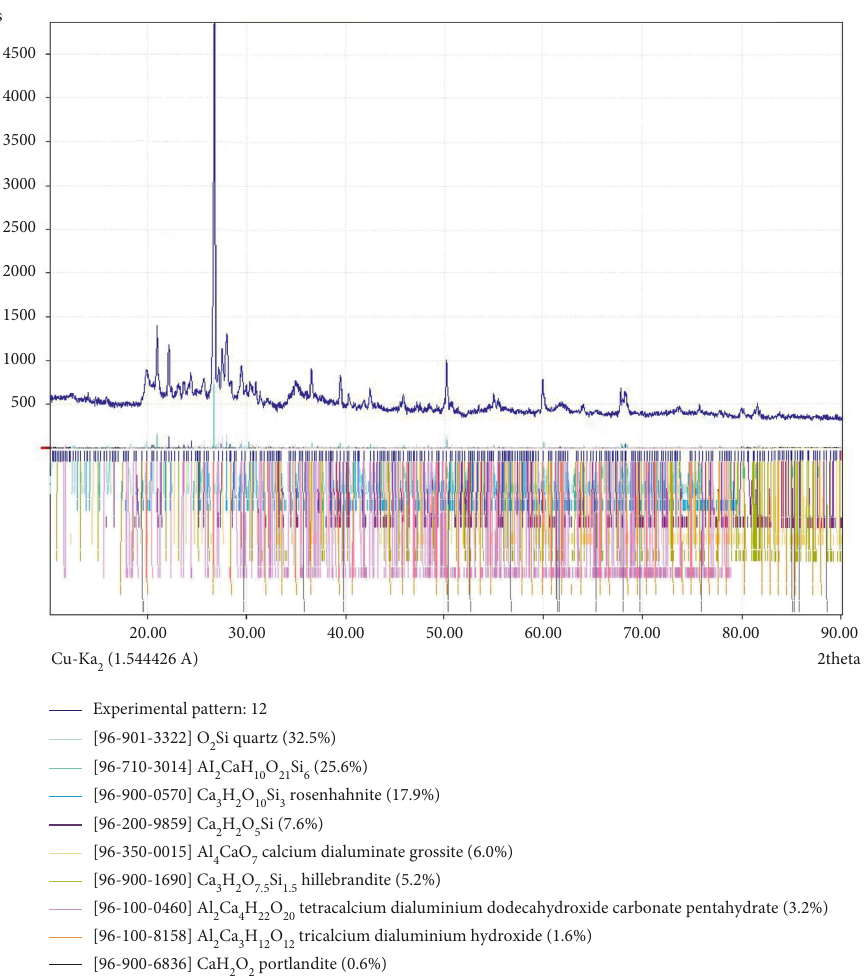
Figure 9: X-ray diffractogram of 7% lime stabilized soil with 0.5%